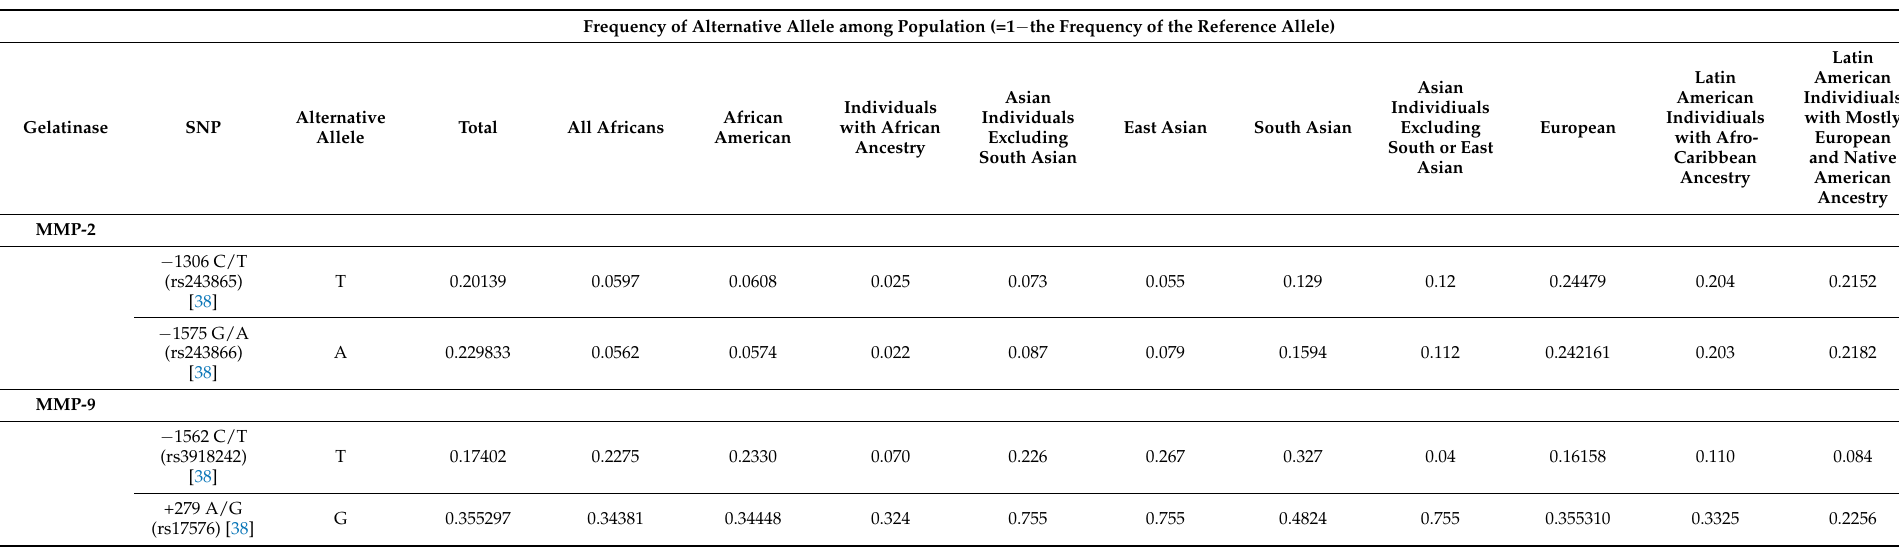
Table 1. The frequency of SNP for of individual polymorphisms of MMP-2 and MMP-9 for general population and the ethnically groups. Frequency of Alternative Allele among Population (=1 − the Frequency of the Reference